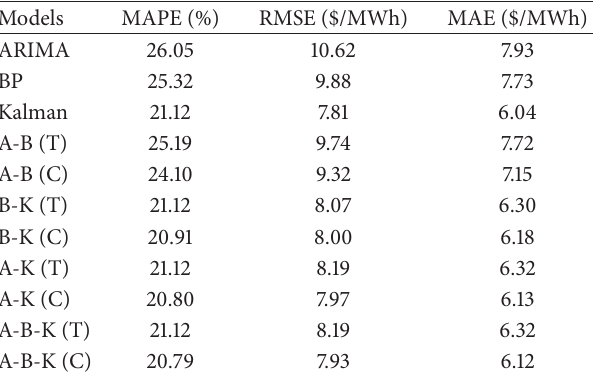
Table 6: Comparison of the performance of different forecasting